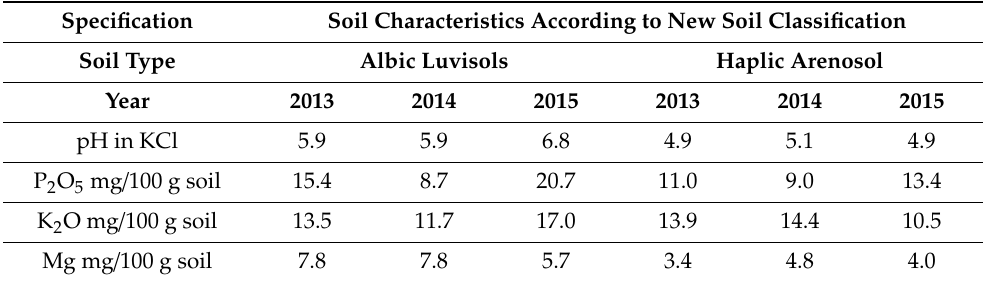
Table 1. Nutrient content and soil pH of the experimental field in AAC Szepietowo in 2013–2015.